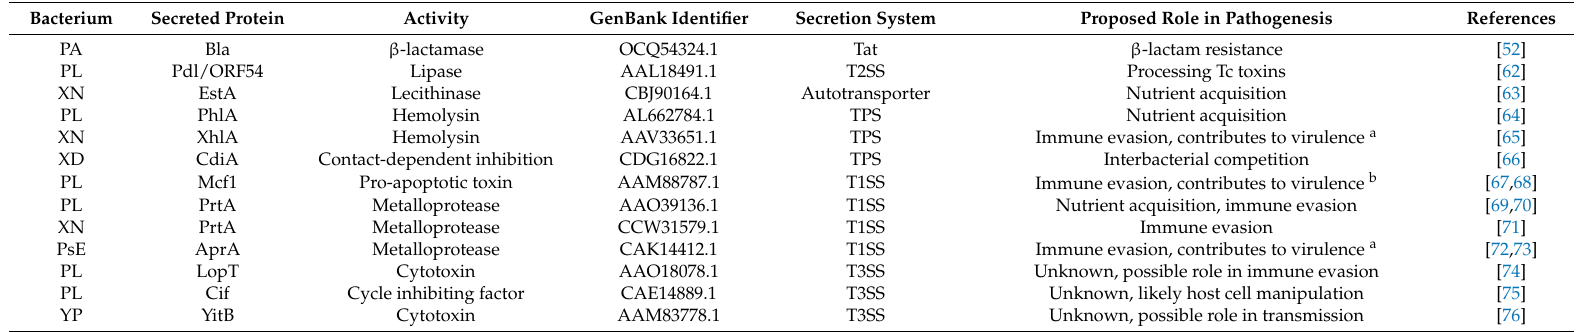
Table 2. Examples of proteins secreted by entomopathogenic